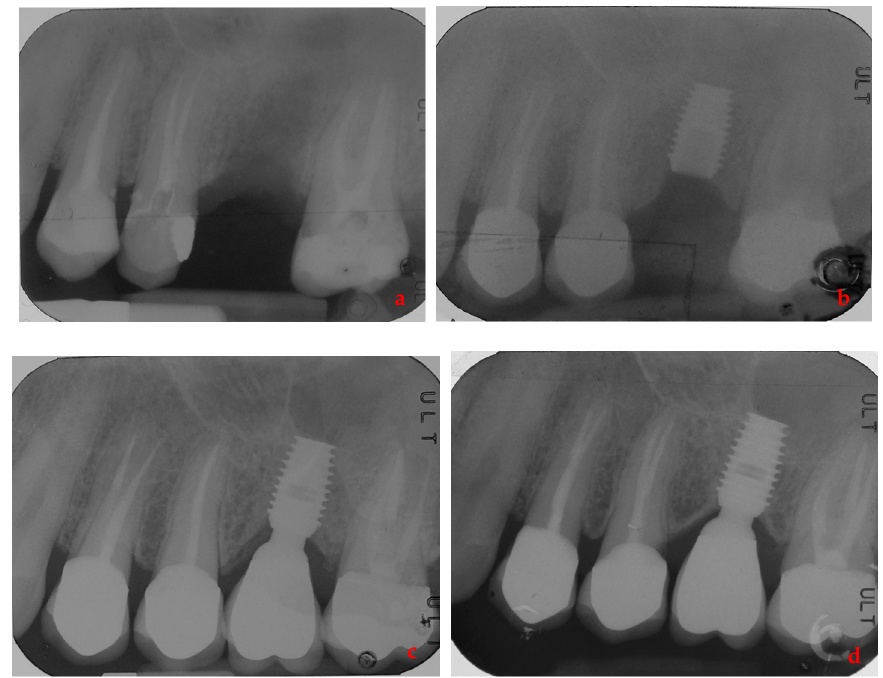
Figure 3. Single implant placed in 2.6 site (4.5 × 8 mm) of a male patient without history of periodontal disease: ( a ) pre-operative radiograph before implant placement; ( b ) radiograph obtained at implant placement; ( c ) radiograph obtained at time of loading; ( d ) radiograph obtained at 3-year follow-up.